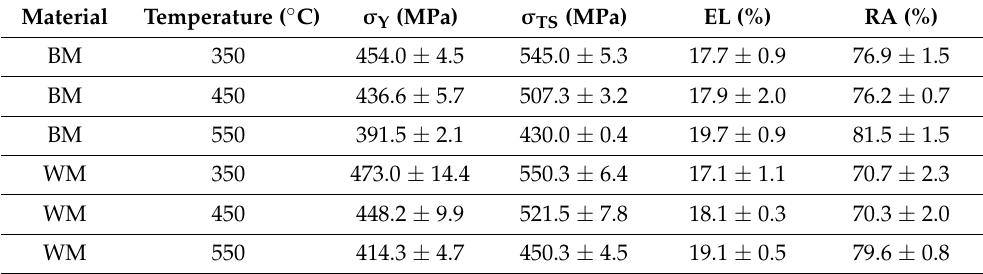
Table 2. Tensile properties of 2.25Cr1Mo0.25V steel BM and WM at high temperatures.